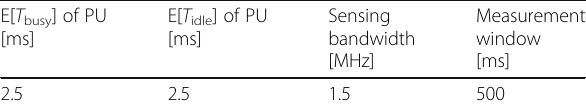
Table 2 Parameters of PU activity and spectrum sensing